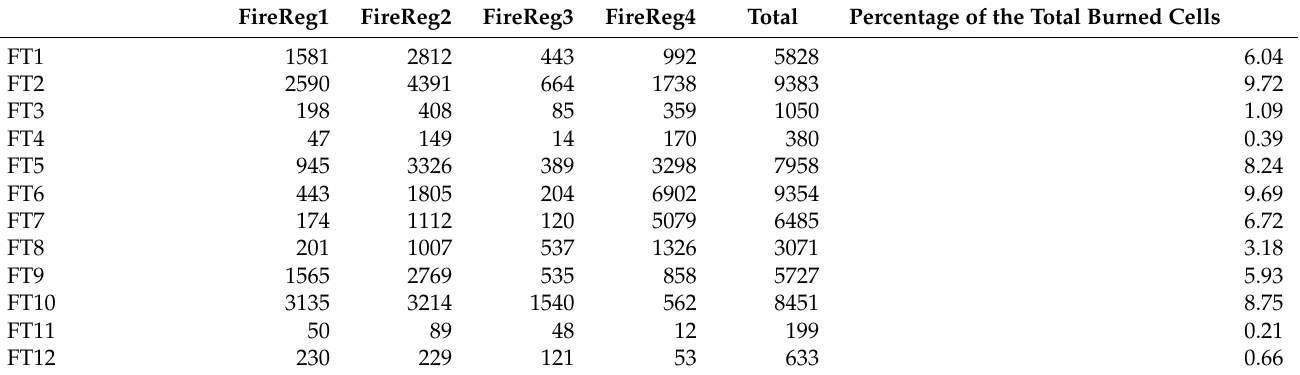
Table A2. Number of grid cells burned for each fuel type (FT) and fire regime (FireReg).